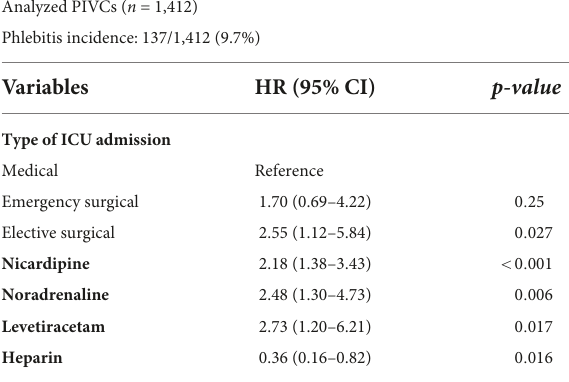
TABLE 5 Marginal Cox regression analysis for phlebitis in the normal weight group.